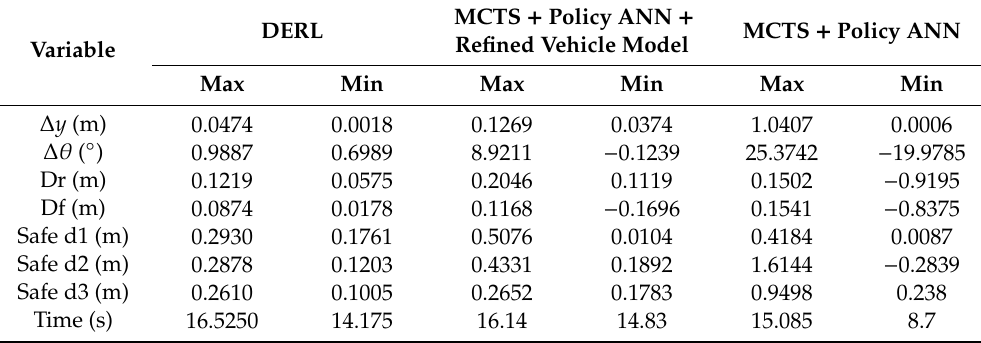
Table A3. Test extreme results for changing initial poses for 20 × 3 parking